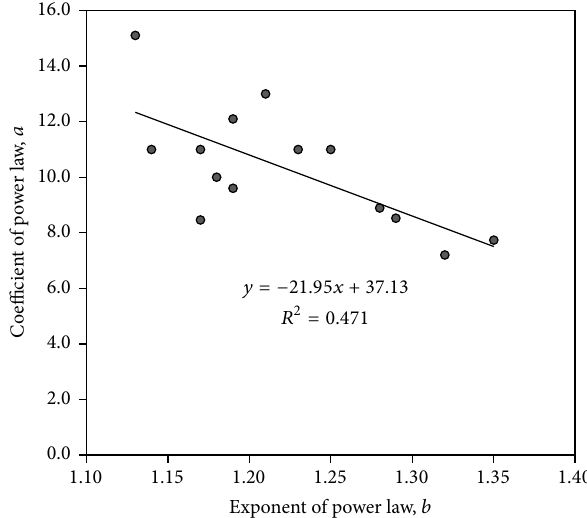
Figure 1: Relationship between coefficients and exponents of empirical power